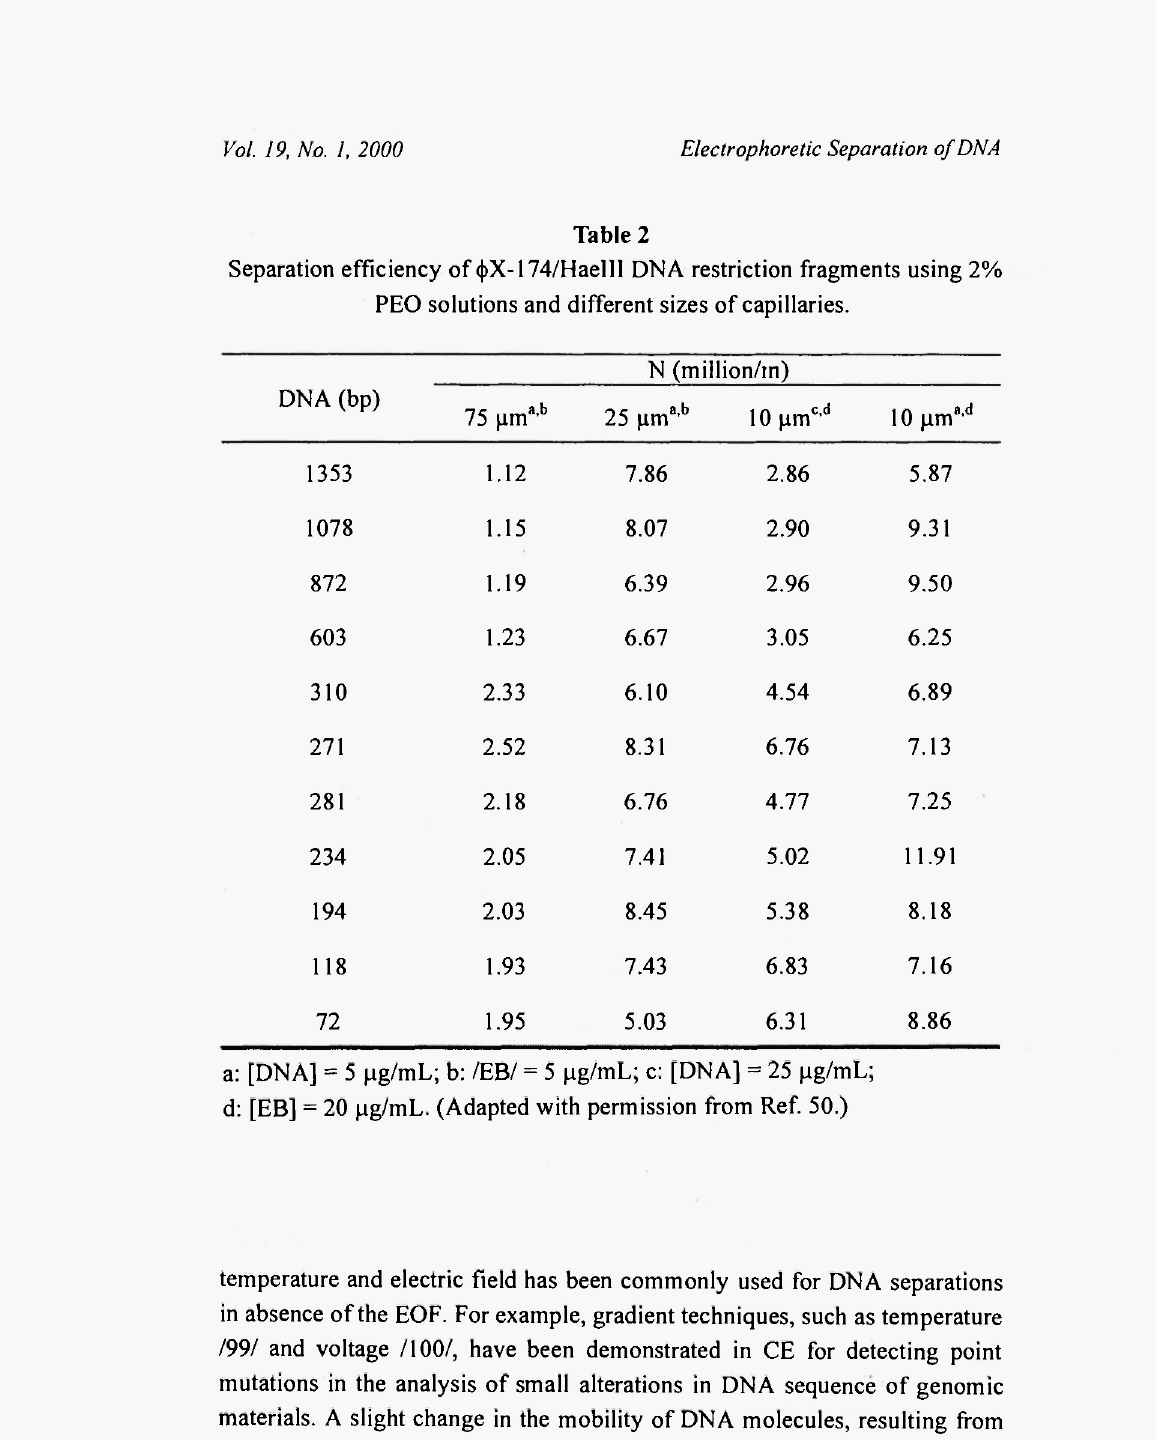
Separation efficiency of φΧ-174/HaeIII DNA restriction fragments using 2% PEO solutions and different sizes of